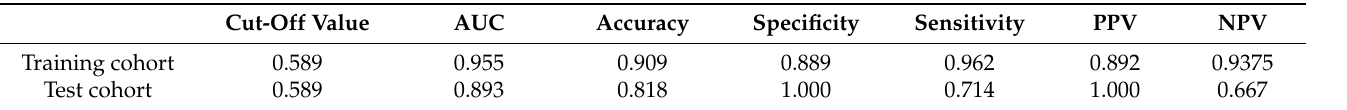
Figure 4. ROC curves of radiomics model in the training and test cohorts.